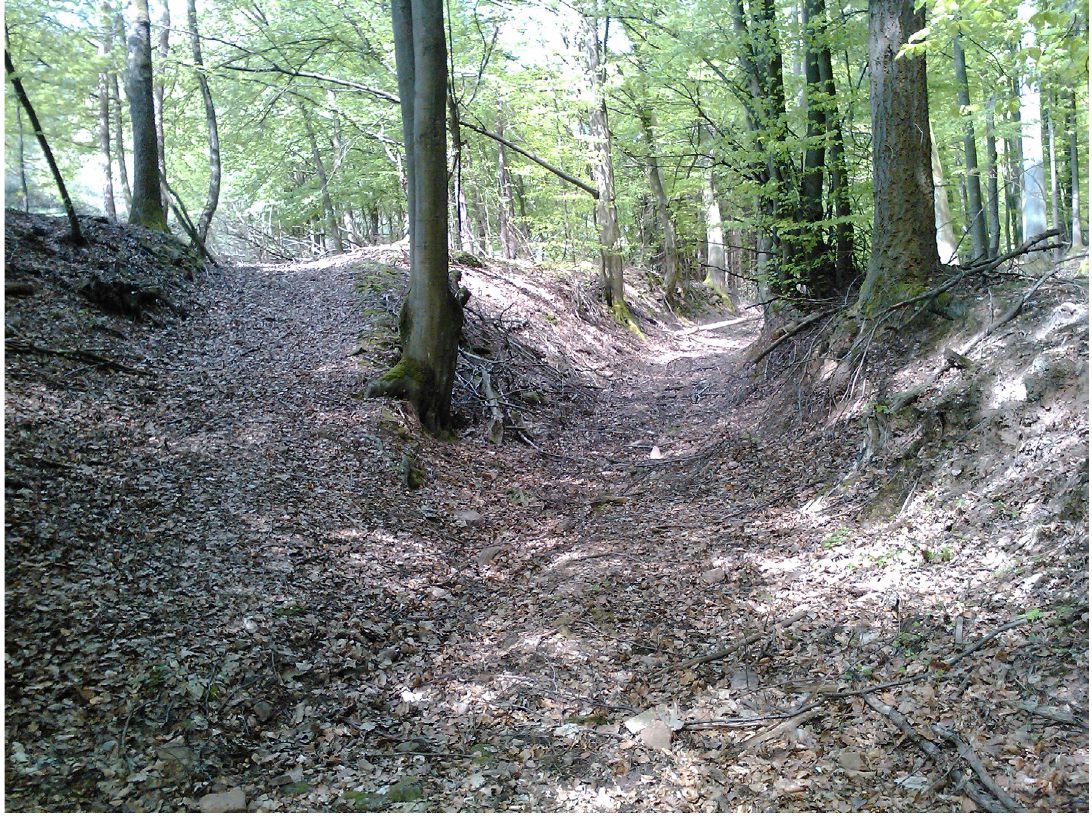
Figure 6. System of parallel, temporarily used sunken paths in the forest near Miltenberg. The image depicts the current appearance of a forested section of path represented in the DTM in Fig. 5 (image